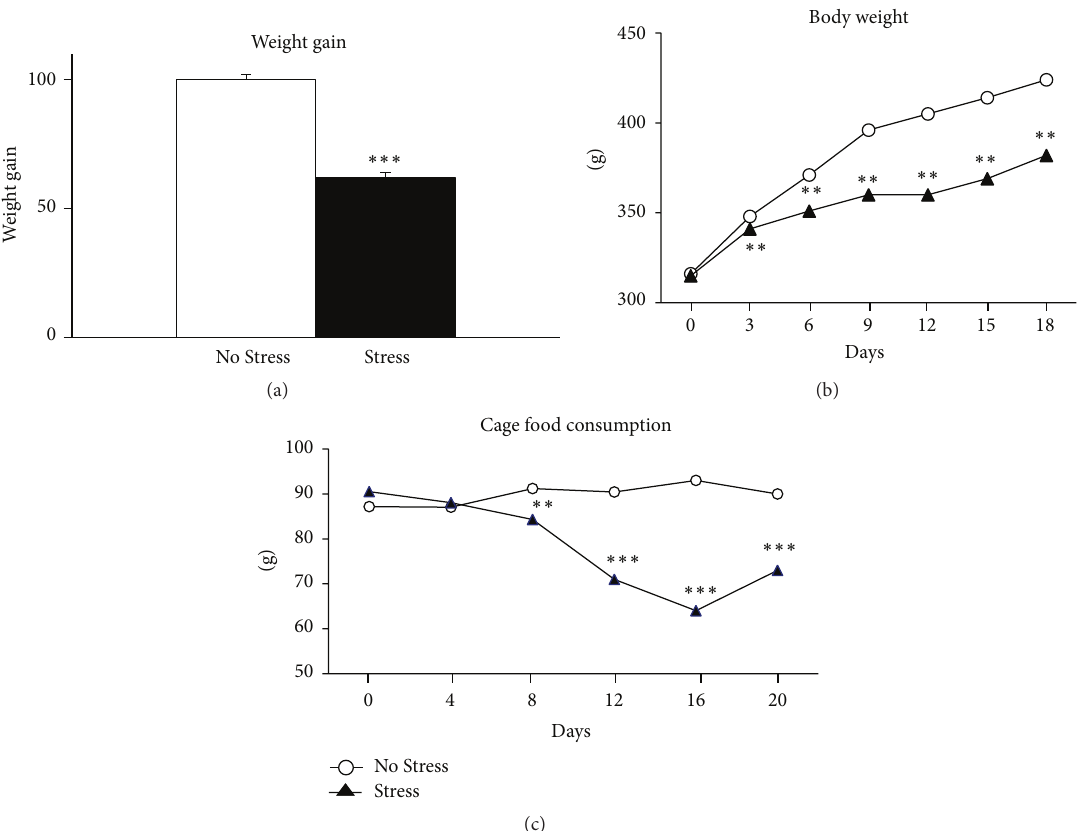
Figure 2: Effects of CMS on weight gain and food consuming behavior. Animals subjected to the stress procedure showed a decrease in body weight, presented as a direct comparison with the control group at 21 days (a) and as a time course during the stress period (b). (c) Showing the profile of food consumption during the 21 days of CMS procedure. ∗∗ 𝑃 < 0.01 , ∗∗∗ 𝑃 < 0.001 versus No Stress animals. Student’s t -test and one-way